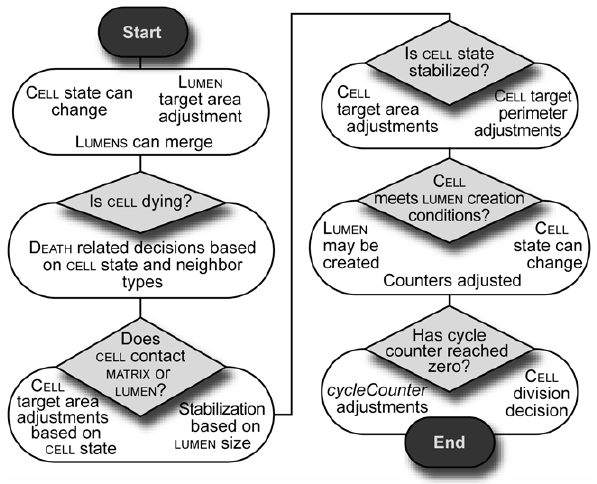
Figure 10. Key features of ISMA logic and decision control flow. During a simulation cycle, each CELL steps through five logic modules sequentially to decide which actions to take based on its local environment and internal state. A LUMEN ’ S target area is adjusted;